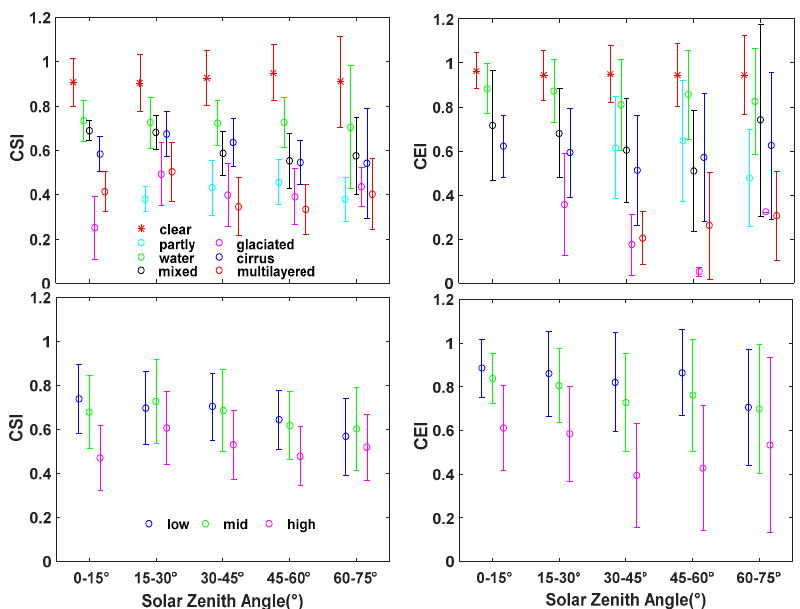
Figure 7. The averaged CSI ( left panel ) and CEI ( right panel ) indices (at 1-min time scale) for cloud types ( upper panel ) and cloud layers ( lower panel ) all plotted against solar zenith angle at the ASF station (not all cloud types have data over a 1-min interval at each solar zenith angle range).